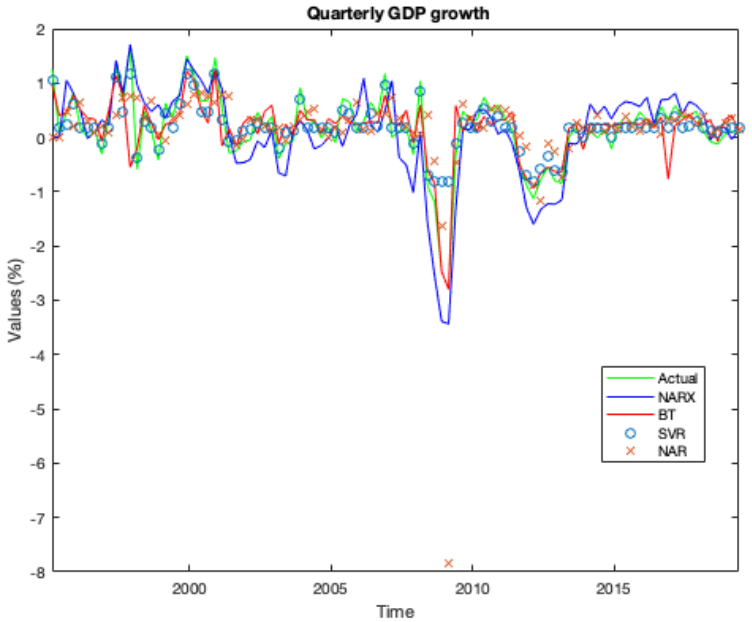
Figure 11. Italian GDP growth rate and the values forecasted by NARX, BT, SVR and NAR models for the period from 1995:Q1 to 2019:Q2 (Data source for GDP growth rate: OECD.Stat, 2019, ‘own elaboration’).